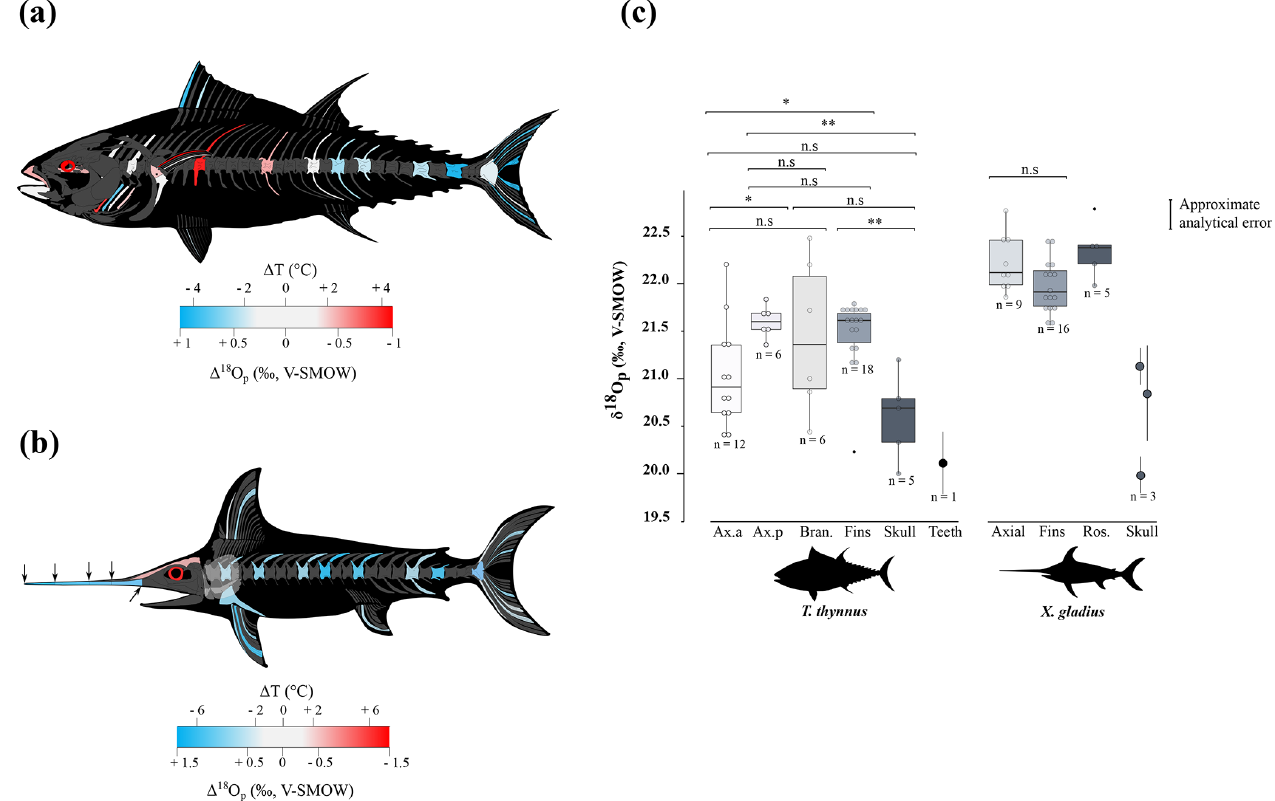
Figure 2. Oxygen isotope variability within the skeleton of T. thynnus (a) and X. gladius (b) . For each specimen, bone (cid:49) 18 O p corresponds to the difference between bone δ 18 O p value and an average value of the skeleton expressed as its mid-range value ( (δ 18 O max − δ 18 O min )/ 2). For paired skeletal elements, as well as vertebrae centra and neural spines and fin spines and rays, the mean value is used. The arrows represented on the swordfish’s skull represents the precise location of the sampling. (c) Boxplots showing the δ 18 O p values of skeletal regions for T. thynnus and X. gladius . Asterisks indicate the significance of the observed differences between pairs of groups: ns (not significant) for p> 0 . 05, ∗ for p< 0 . 05, ∗∗ for p< 0 . 01 (highly significant difference). Outliers are plotted as small black circles. Abbreviations: Ax.a (axial anterior), Ax.p (axial posterior), Bran. (branchial arches), Ros.